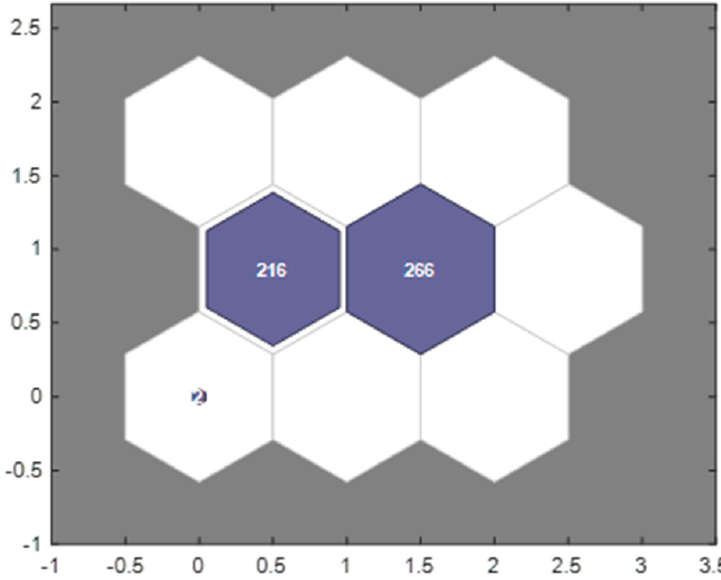
Figure 16. Hit map of the SOM network. Table 5. Comparison of the classification accuracy of two radars by different methods ( − 5